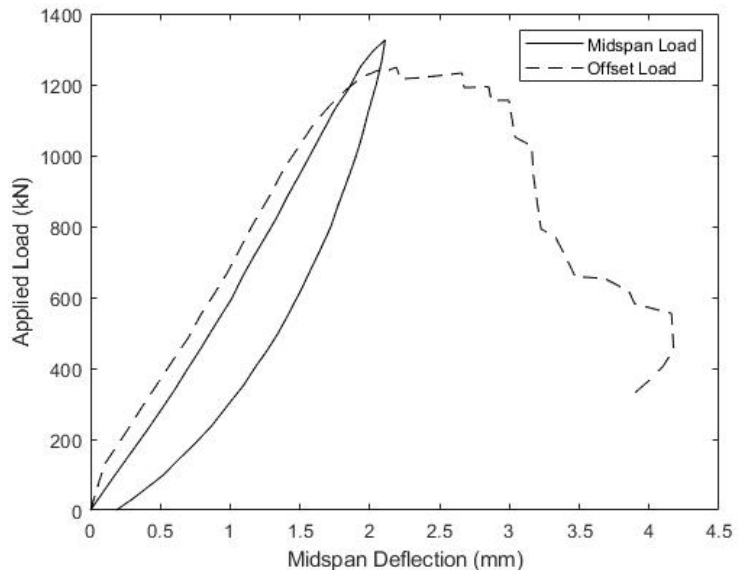
Figure 14. Beam B2 Ultimate Load-Displacement Response.